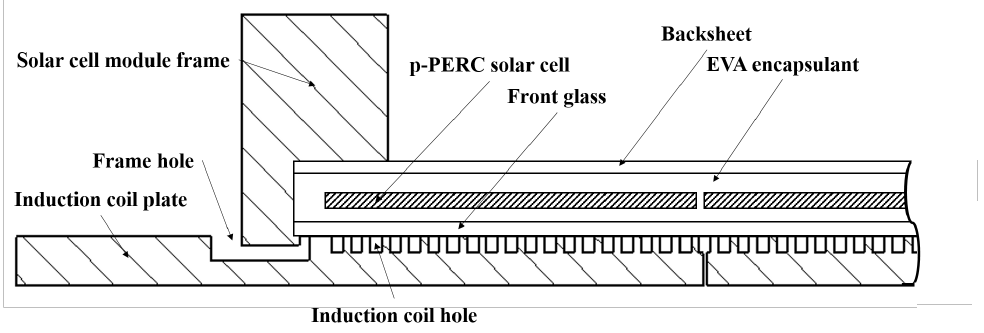
Figure 2. Schematic illustration of a cross section of the p-PERC solar module remote heating